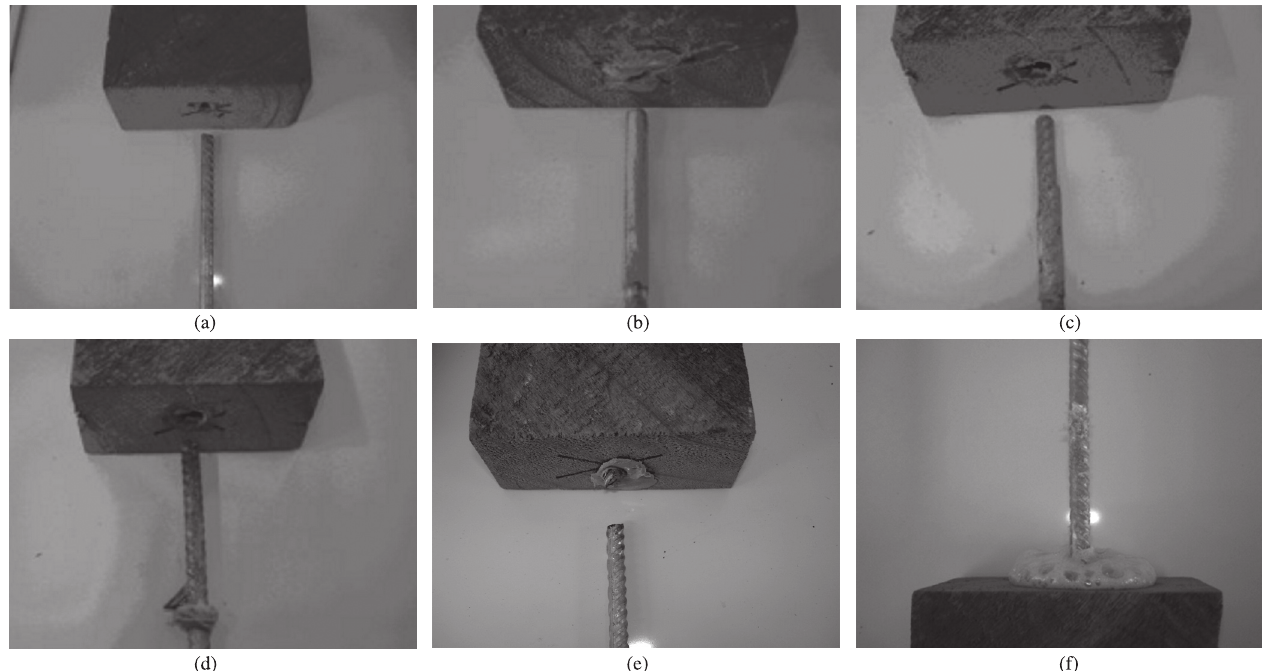
Figure 4. Different failure modes observed in the fatigue